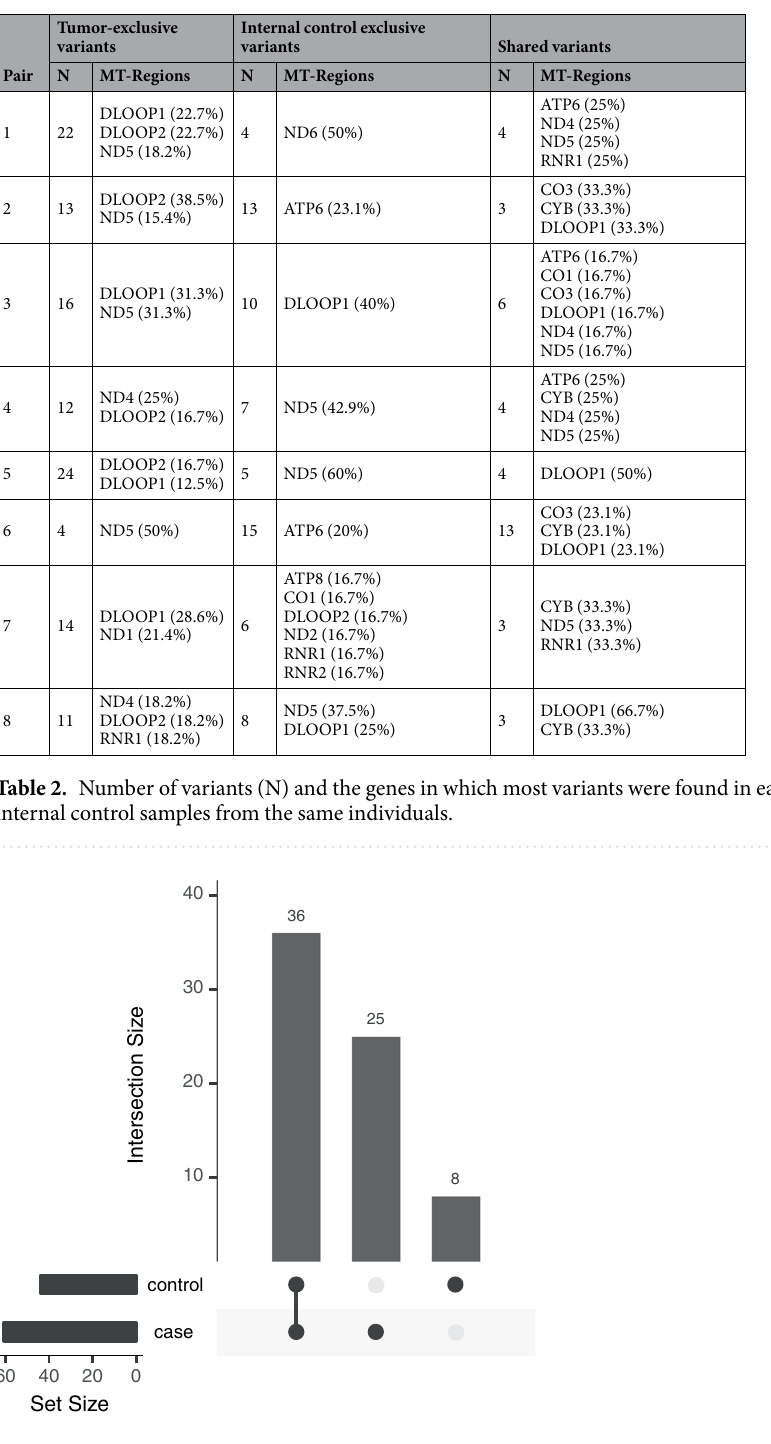
Figure 1. Number of exclusive and shared variants found in the paired samples (tumor and internal control) of gastric cancer patients. Groups are represented by the darker dots. Set size is the sum of variants for each